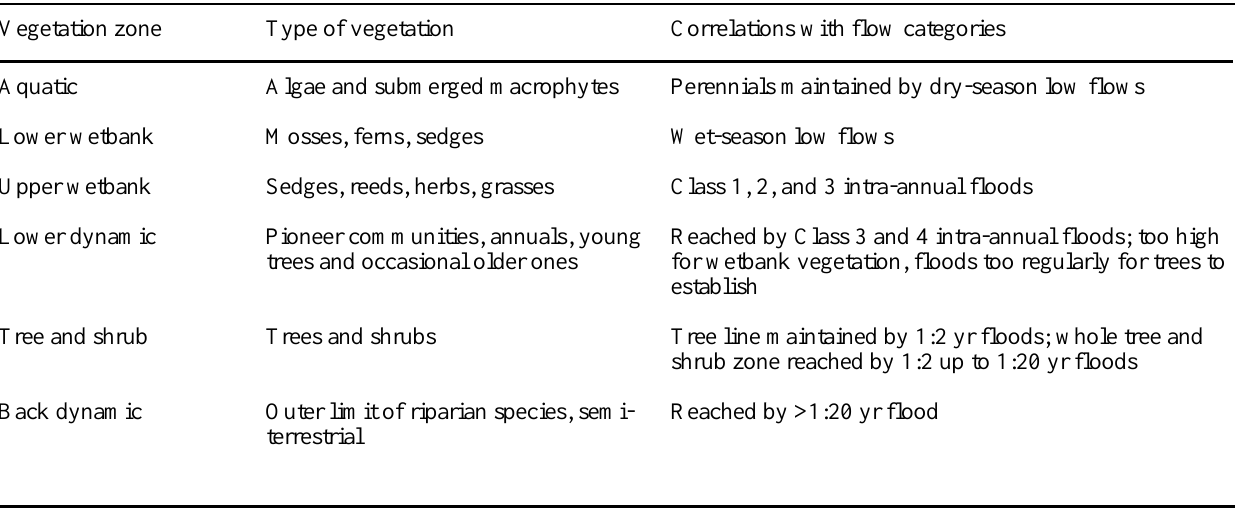
Table 4 . Possible links between vegetation zones and flow categories in southern African rivers (modified from Boucher